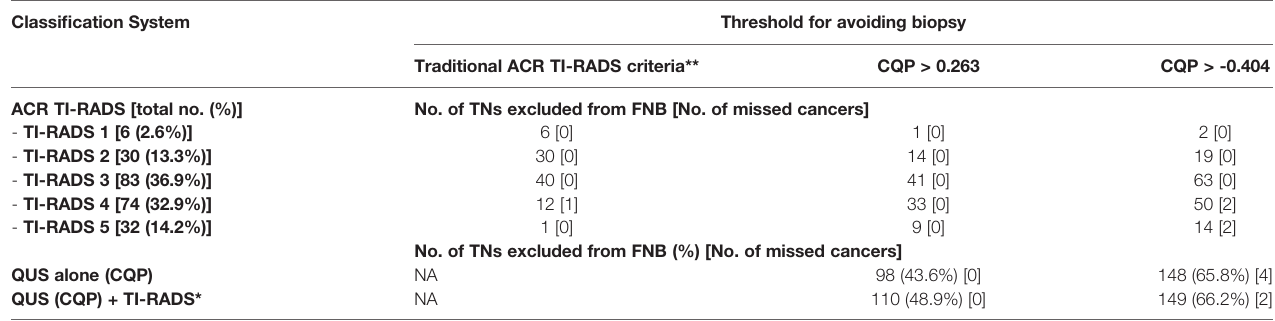
TABLE 4 | Number of nodules excluded from biopsy of the 225 TN cohort based on ACR-TIRADS using recommended size threshold vs in combination with QUS parameter (CQP) cutoffs. Classi fi cation System